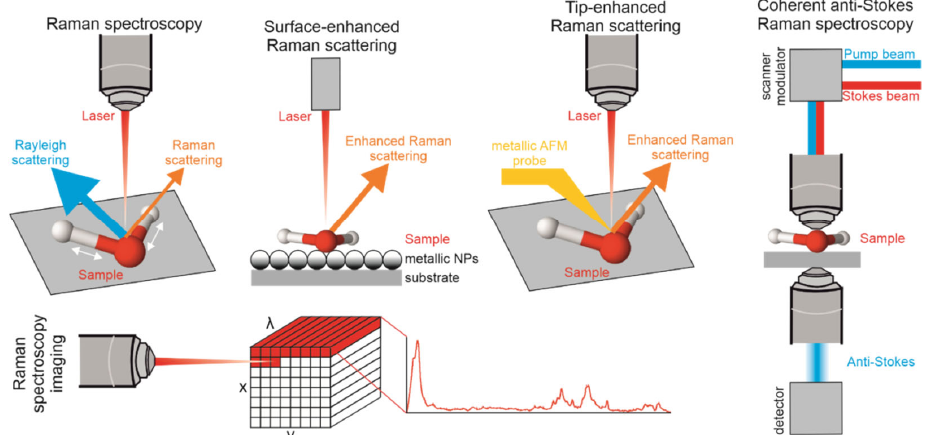
Figure 3. The main Raman techniques implemented to biopolymer analysis: Raman spectroscopy, SERS, TERS, CARS, and Raman spectroscopic imaging (microspectroscopy).